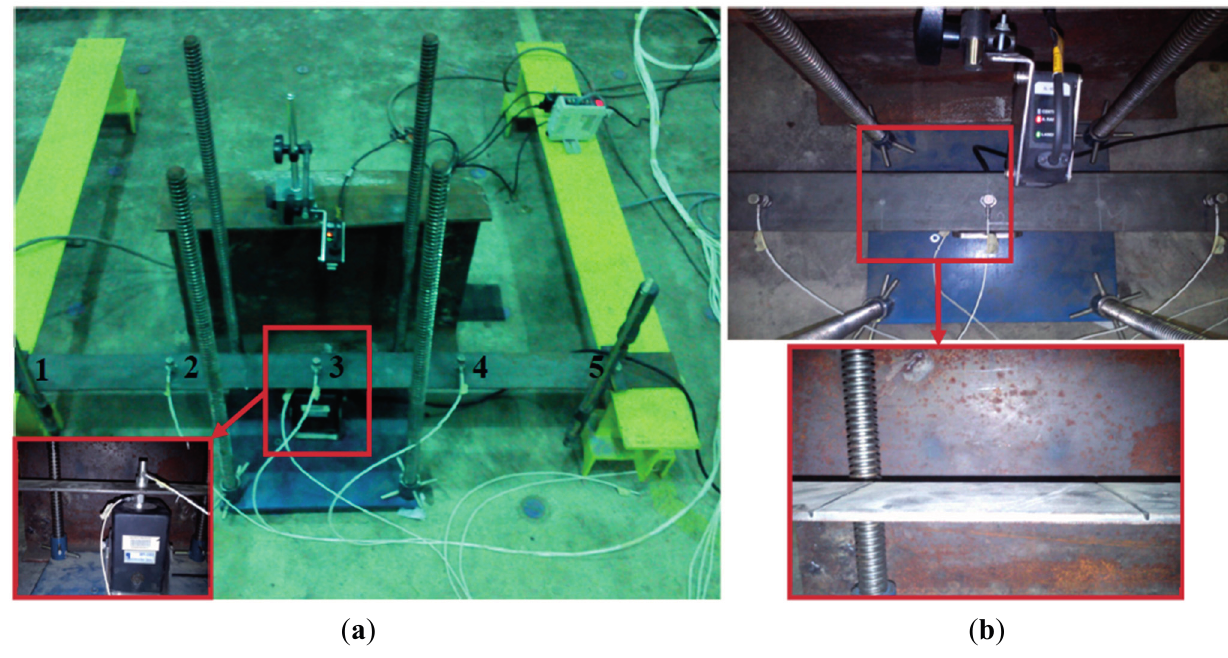
Figure 12. ( a ) Experimental setup and data acquisition system; ( b ) damage locations of tested beam.